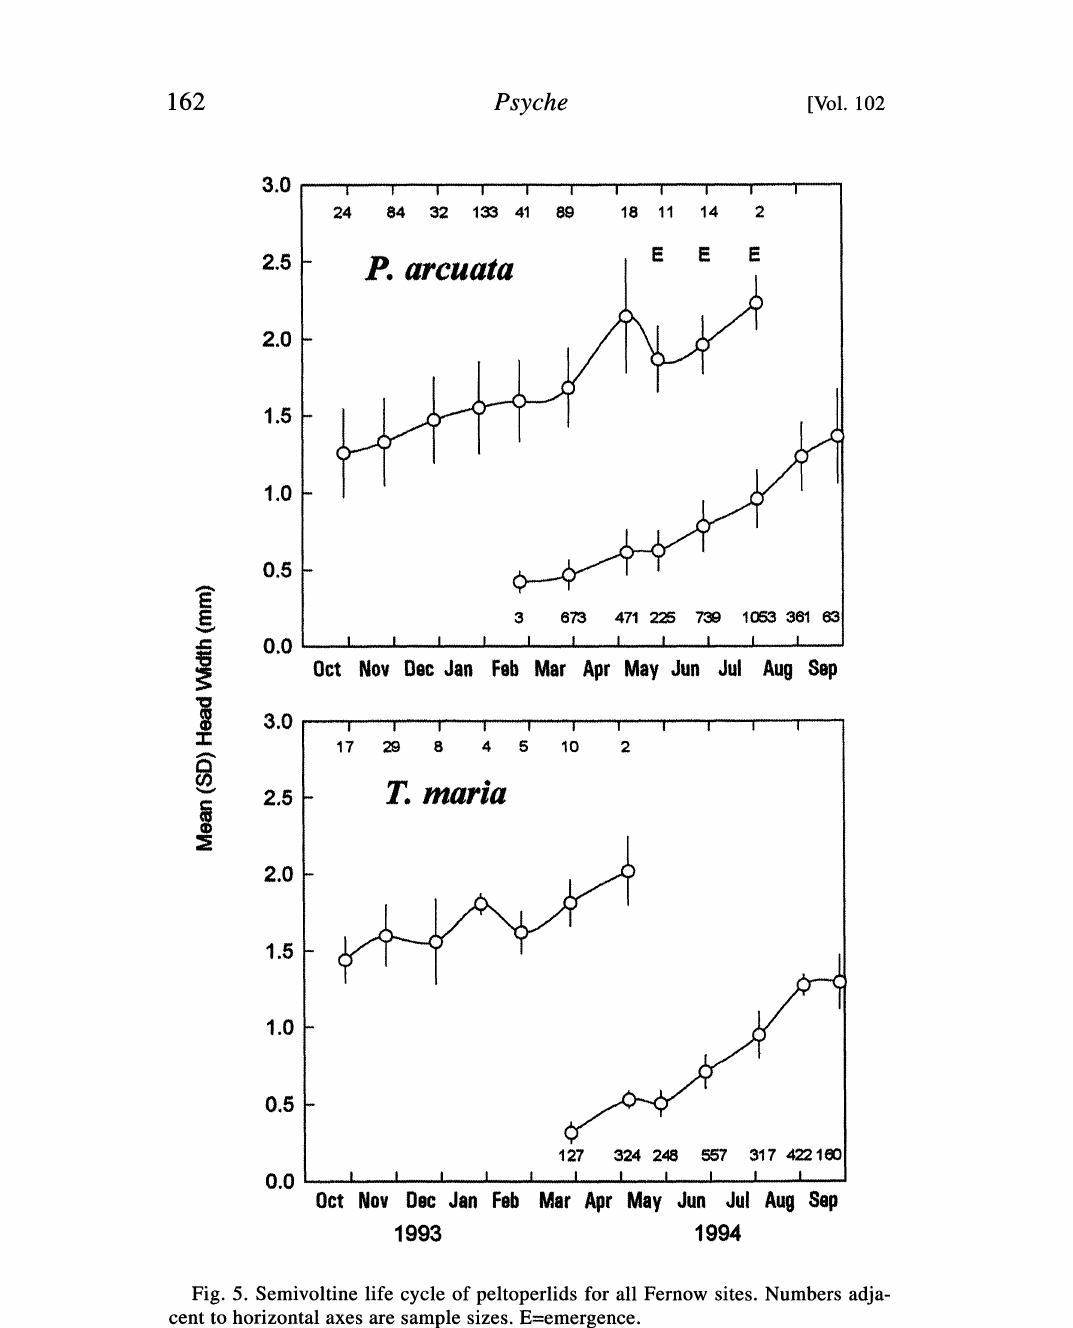
Fig. 5. Semivoltine life cycle of peltoperlids for all Fernow sites. Numbers adja- cent to horizontal axes are sample sizes.